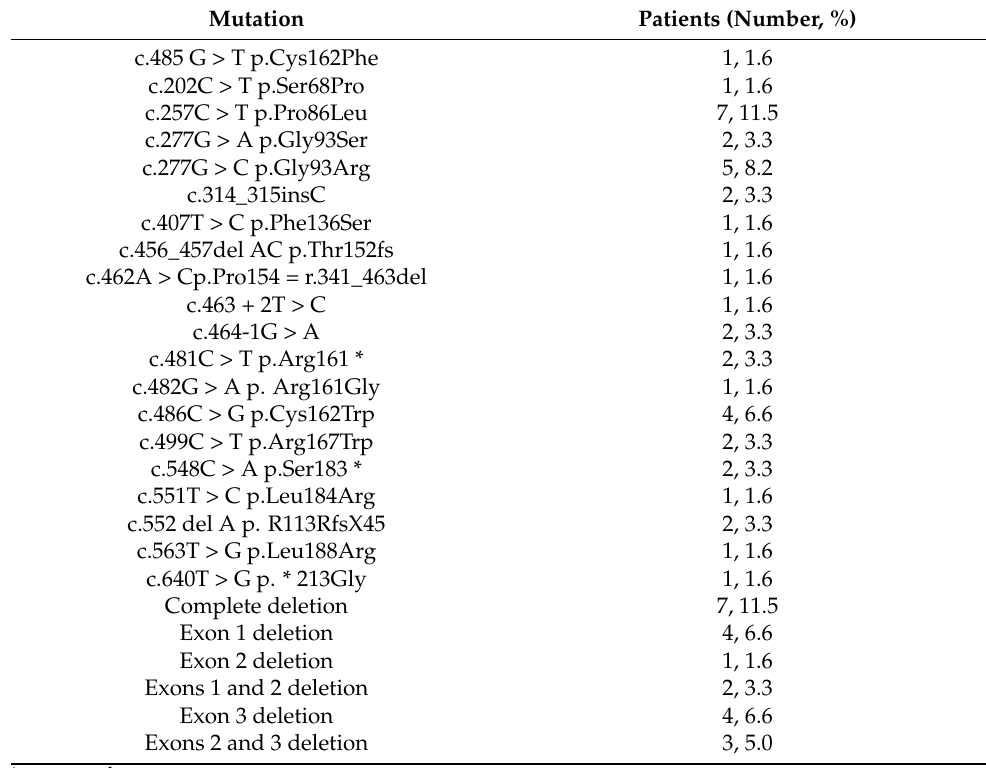
Table 1. Mutation reported in the VHL